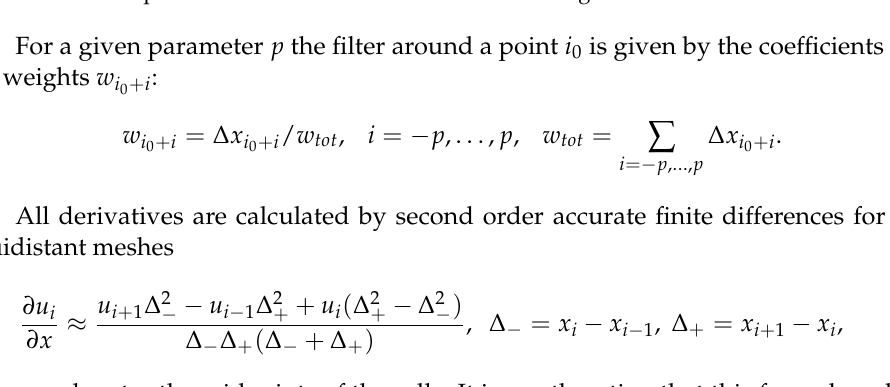
Figure 1. Illustration of the stretched 1D computational mesh with cell centred data storage and one sketched box